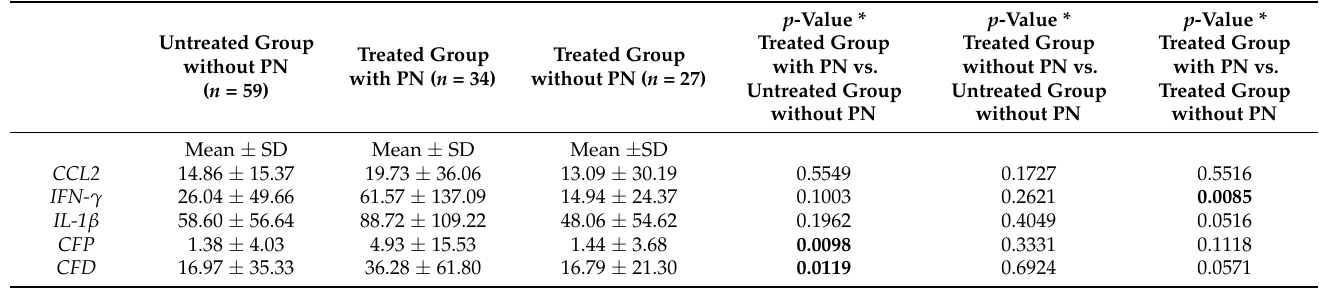
Table 2. Relative quantification of gene expression normalized by the BMG gene in patients with MM. Untreated Group without PN